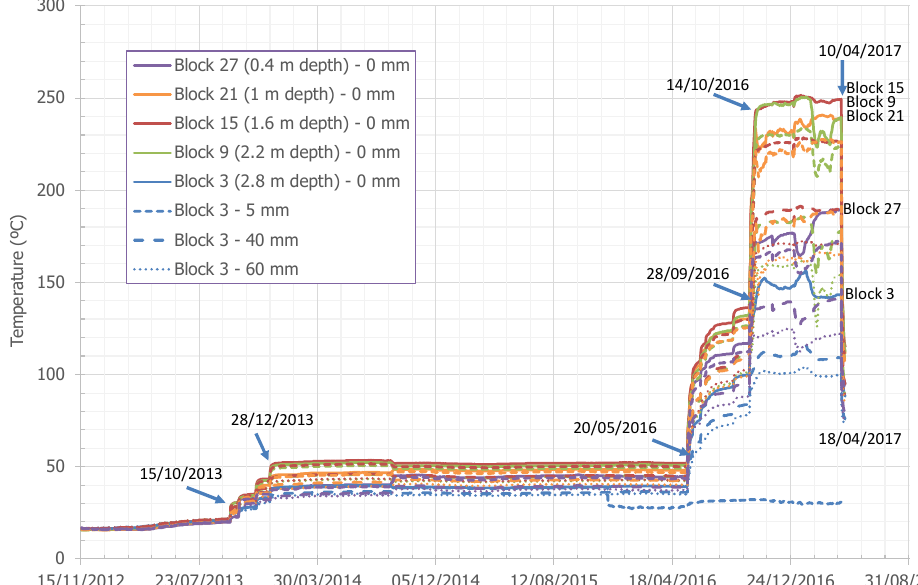
Figure 1. Schematic design of the ABM5 test package (after [16], courtesy of SKB). In red: samples analysed in this study. In blue: block containing thermocouples and Cu and Ti coupons. Colours represent different types of bentonites.